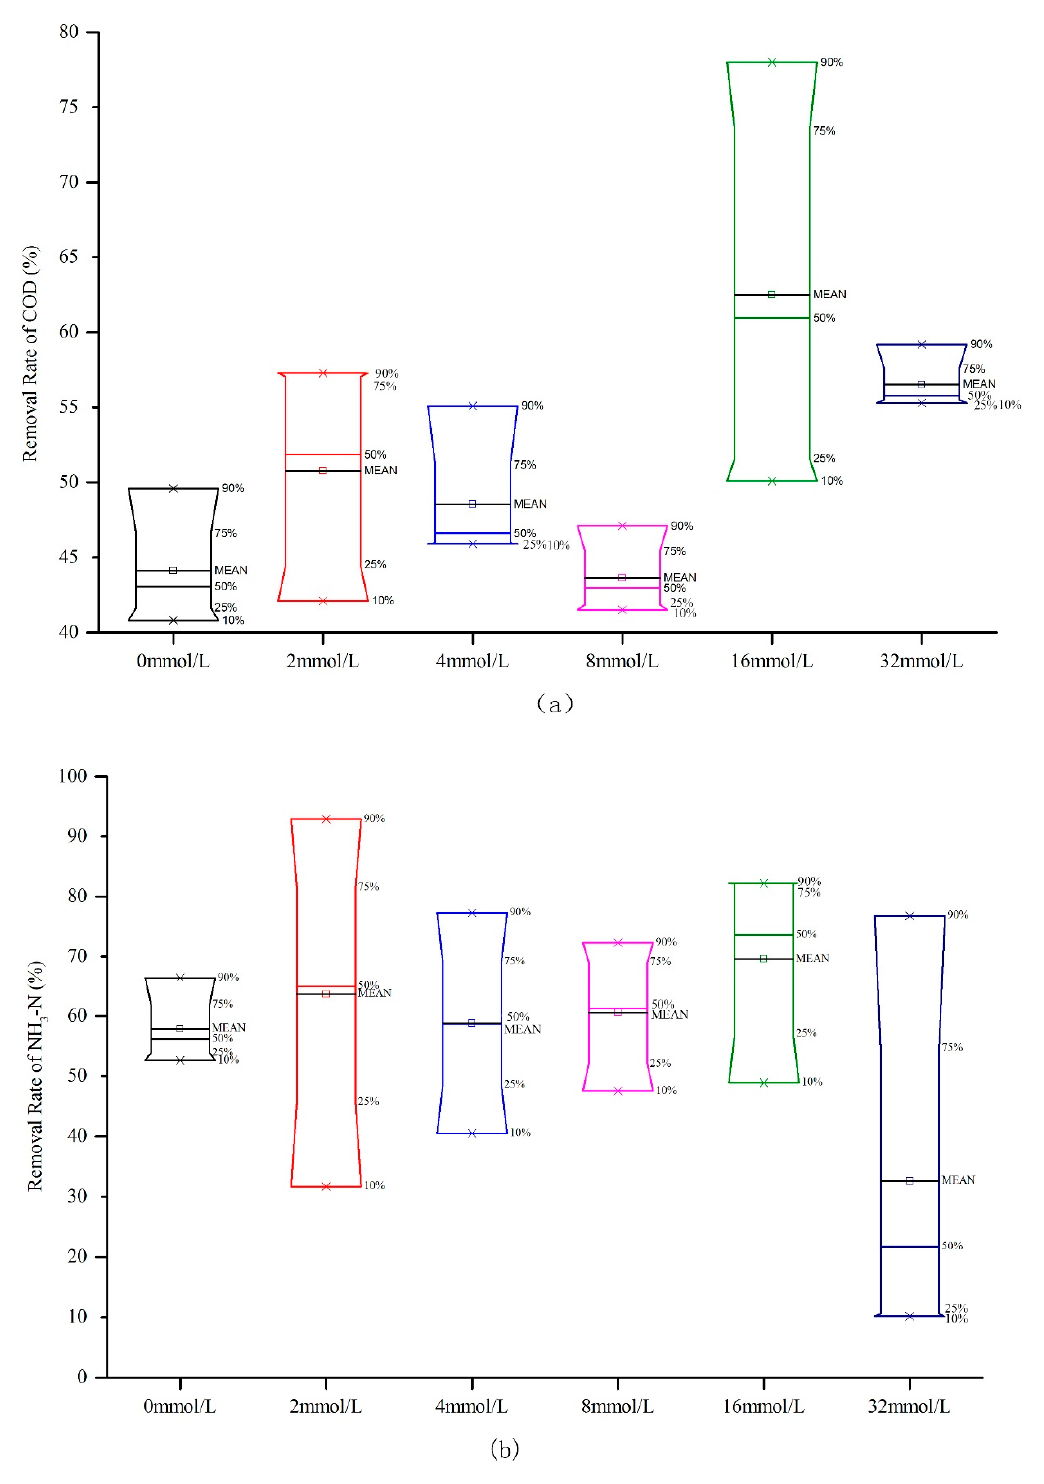
Figure 4. Removal rate of the chemical oxygen demand (COD) ( a ) and NH 3 -N ( b ) with a gradient ethanol concentrations .